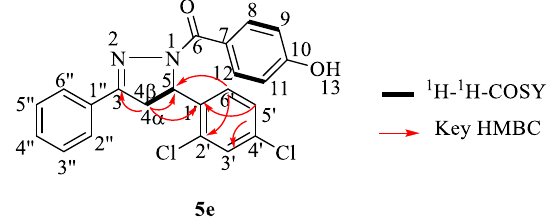
Figure 3. Key COSY/HMBC correlations of compound 5e .